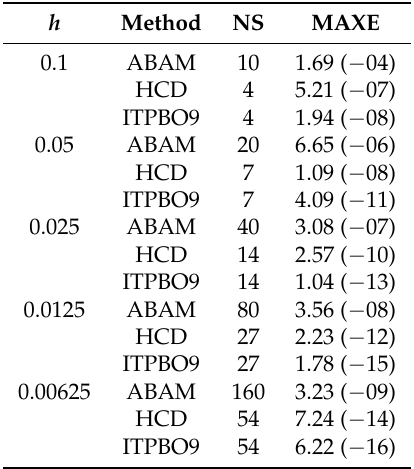
Table 2. Comparison of the maximum absolute errors on Problem 1.